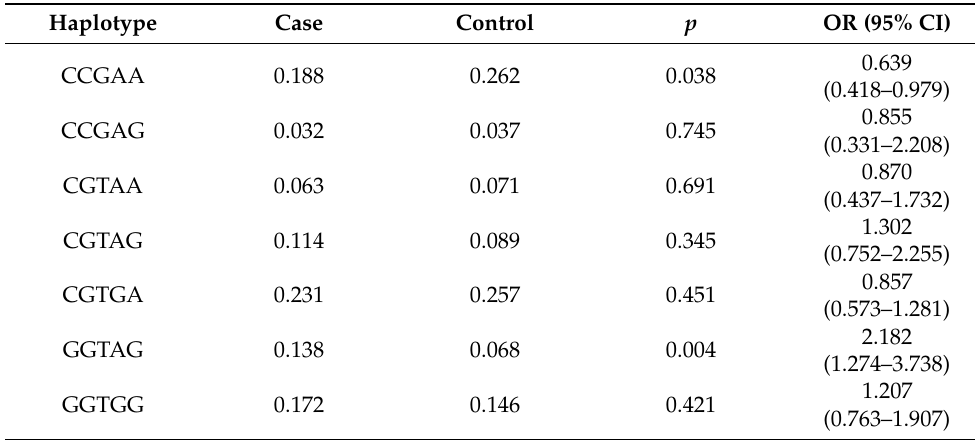
Figure 3. ADIPOQ gene linkage disequilibrium and haplotype block structure. Value in cells indicate logarithm of odds (LOD)score of D’. Table 5. Haplotype frequency distribution of ADIPOQ